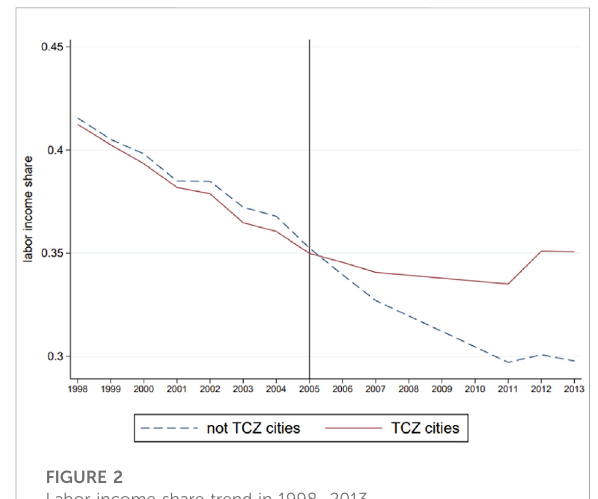
FIGURE 2 Labor income share trend in 1998 – 2013.